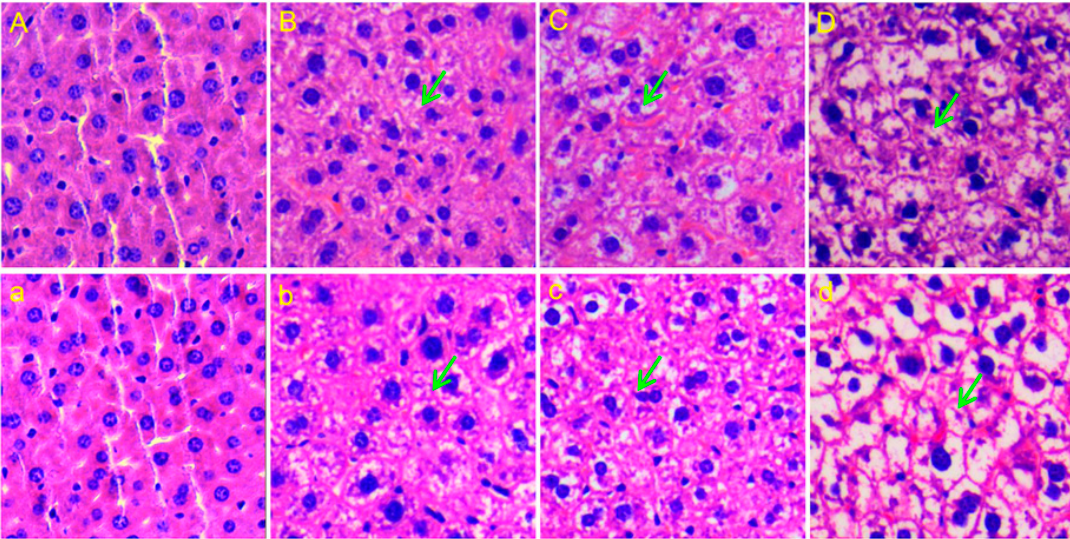
Figure 1. Representative histopathology sections of liver after treated with rac- metalaxyl: ( A ) control; ( B ) 10 mg/kg; ( C ) 30 mg/kg; ( D ) 60 mg/kg); and, metalaxyl-M: ( a ) control; ( b ) 10 mg/kg; ( c ) 30 mg/kg; ( d ) 60 mg/kg). The green arrows indicated hepatocellular necrosis and vacuolation.